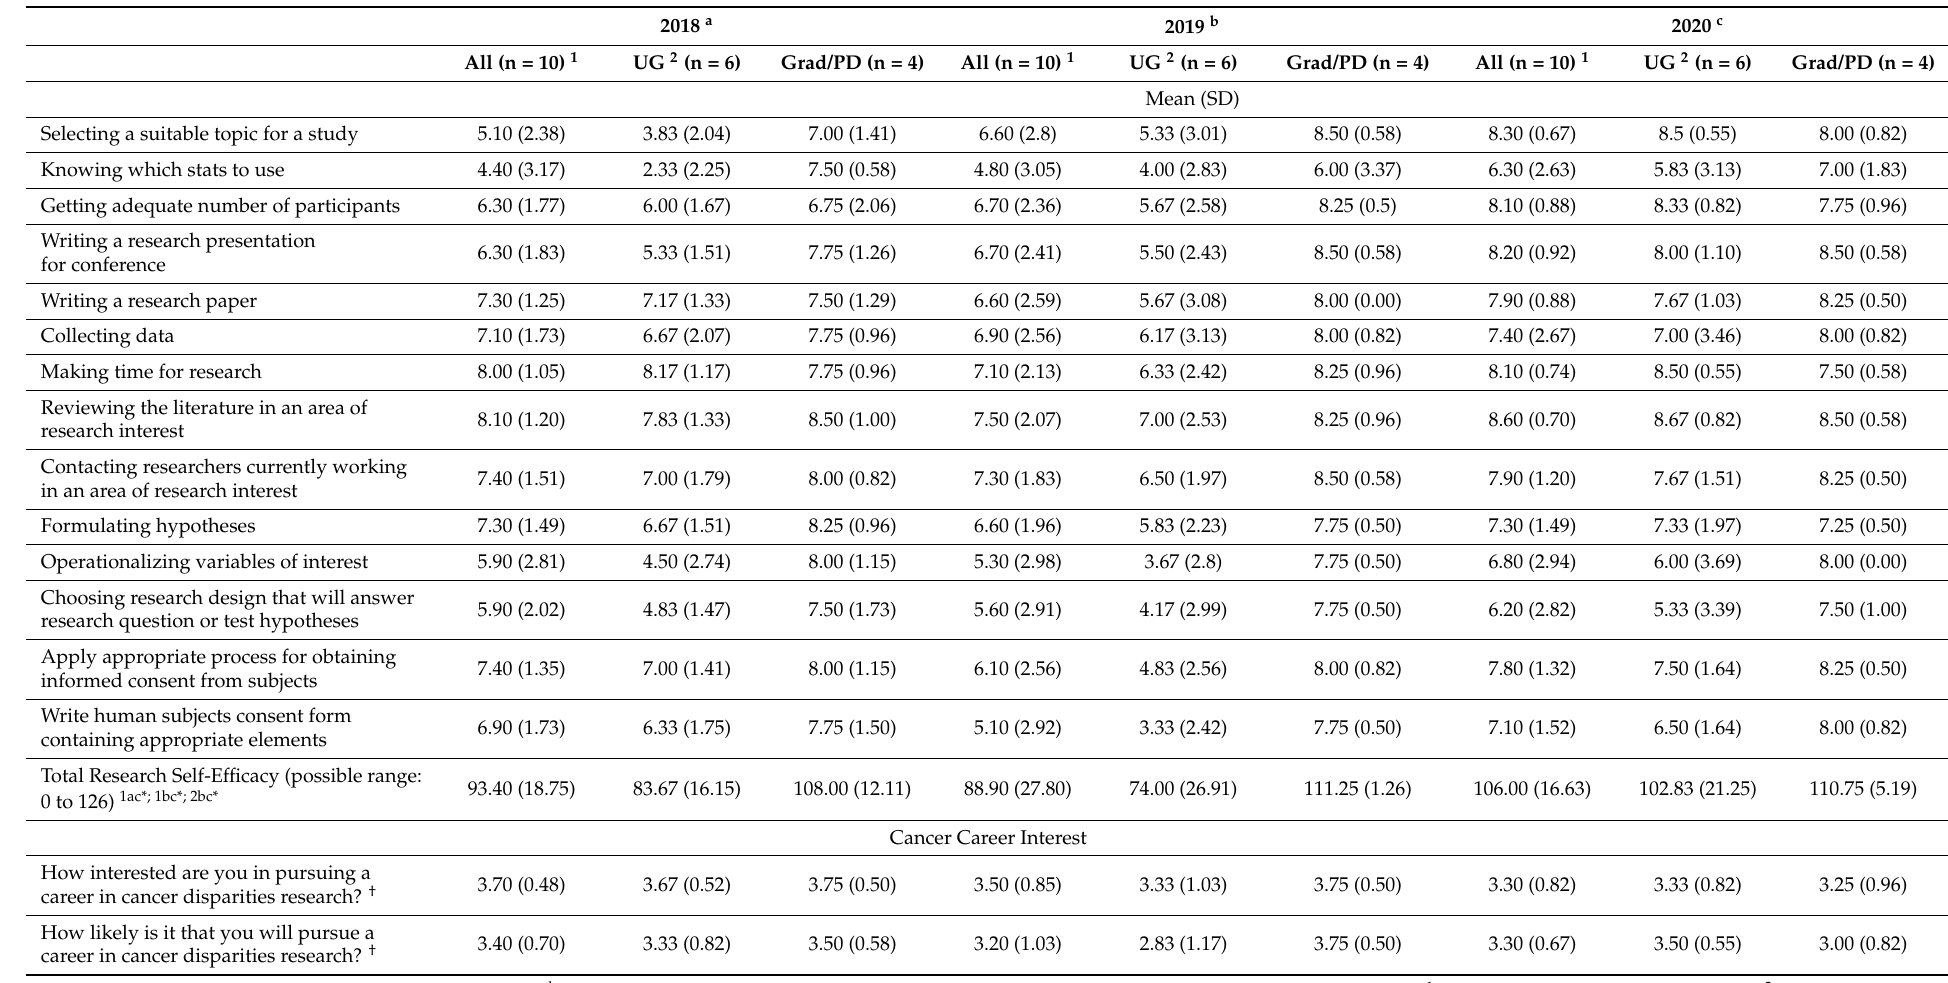
Table 2. Research Self-Efficacy and Cancer Career Interest by Scholar Groups and Year (N =